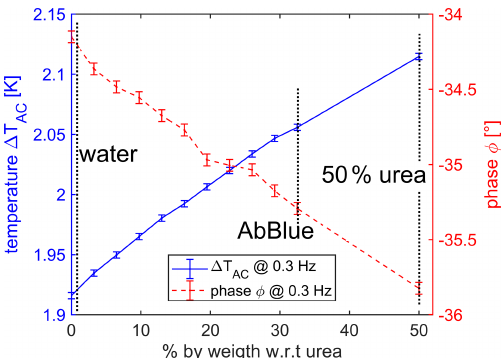
Figure 8. The oscillation amplitude (cid:49)T AC as a function of urea concentration (blue solid line) and phase φ as a function of urea concentration (red dashed line). In both cases, a clear correlation between urea concentration and the signal is shown with an esti- mated resolution of 1% by